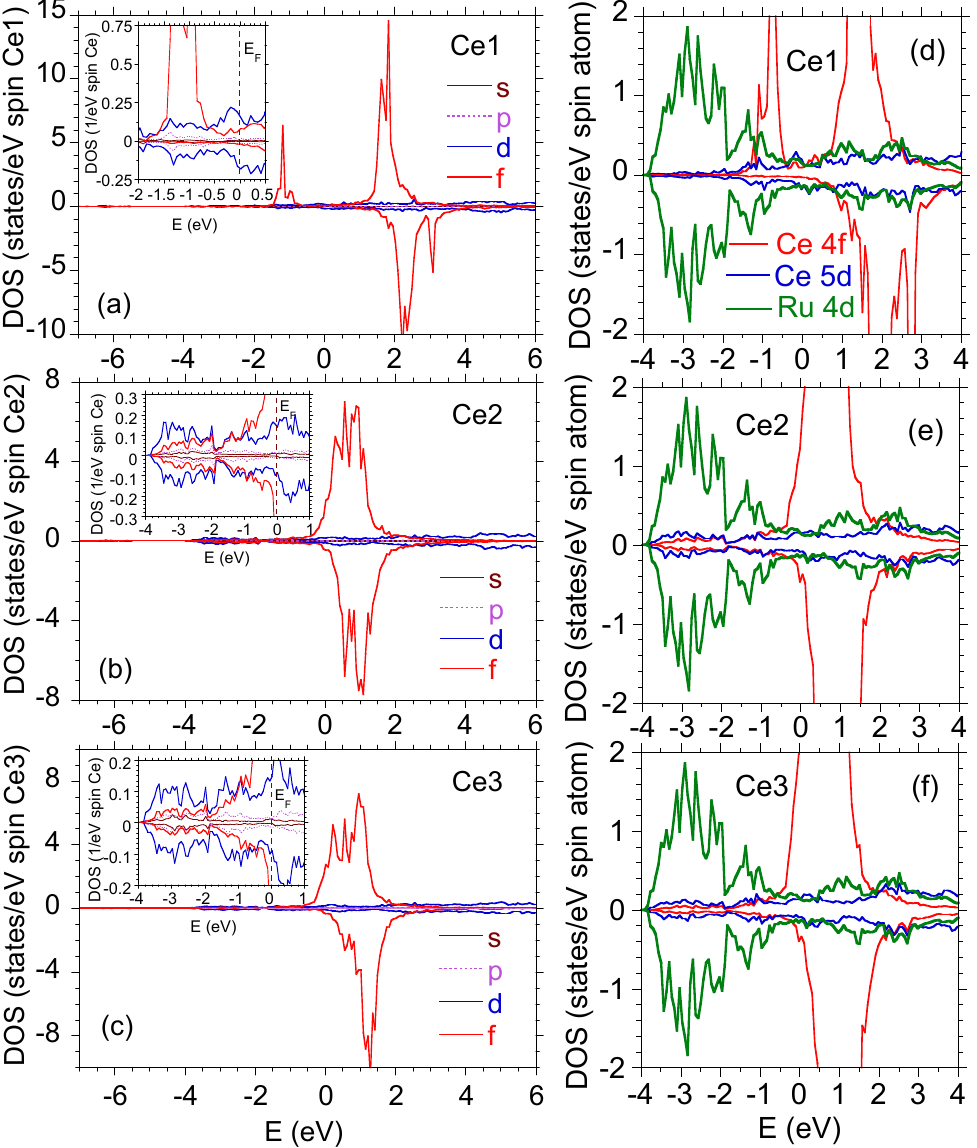
Figure 5. Spin-resolved density of states in Ce 9 Ru 4 Ga 5 due to ( a ) Ce1,( b ) Ce2, and ( c ) Ce3 atoms. The density of states (DOS) calculations were performed for the correlation parameters U = 3 eV for Ce1, and U = 2.25 eV for Ce1 and Ce2. The insets present in details the 5 d contributions. The right panels ( d – f ) show partial density of states in Ce 9 Ru 4 Ga 5 due to Ce 5 d and Ru 4 d electrons at Ce1 ( d ), Ce2 ( e ), and Ce3 ( f ) sites. The DOS calculations were performed for the correlation parameters U = 3 eV for Ce1 atom, and U = 2.25 eV for Ce2 and Ce3 atoms.